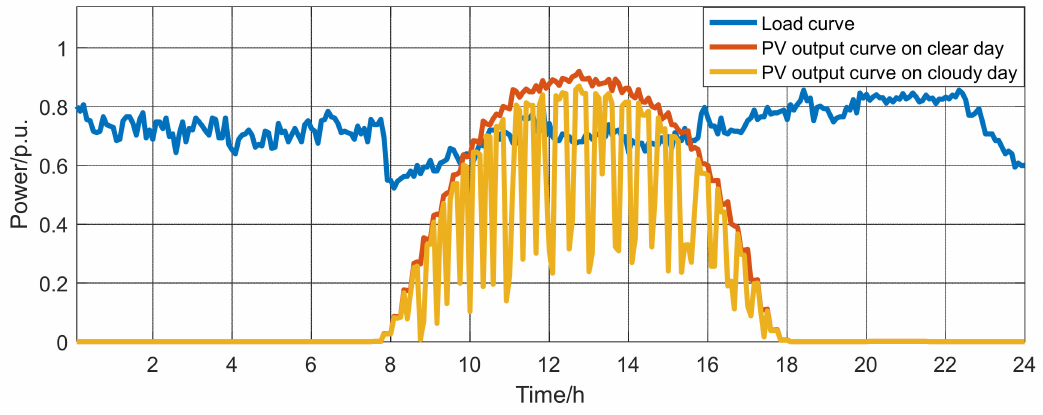
Figure 5. The load data and PV output data in the test set. First, based on the optimal power flow, the voltage distribution of this grid without any voltage control was analyzed. In this paper, the interval T was defined as 30 min and the slot t was assumed to be 5 min. The PV outputs were based on the clear day in Figure 5. The buses experiencing voltage issues were bus 1, bus 2, bus 7, and bus 123, which violated the maximum voltage limit of 1.05. Take for example the voltage amplitudes at bus 1 and bus 24 (with PV unit installation), which are depicted by the blue curve in Figure 6.